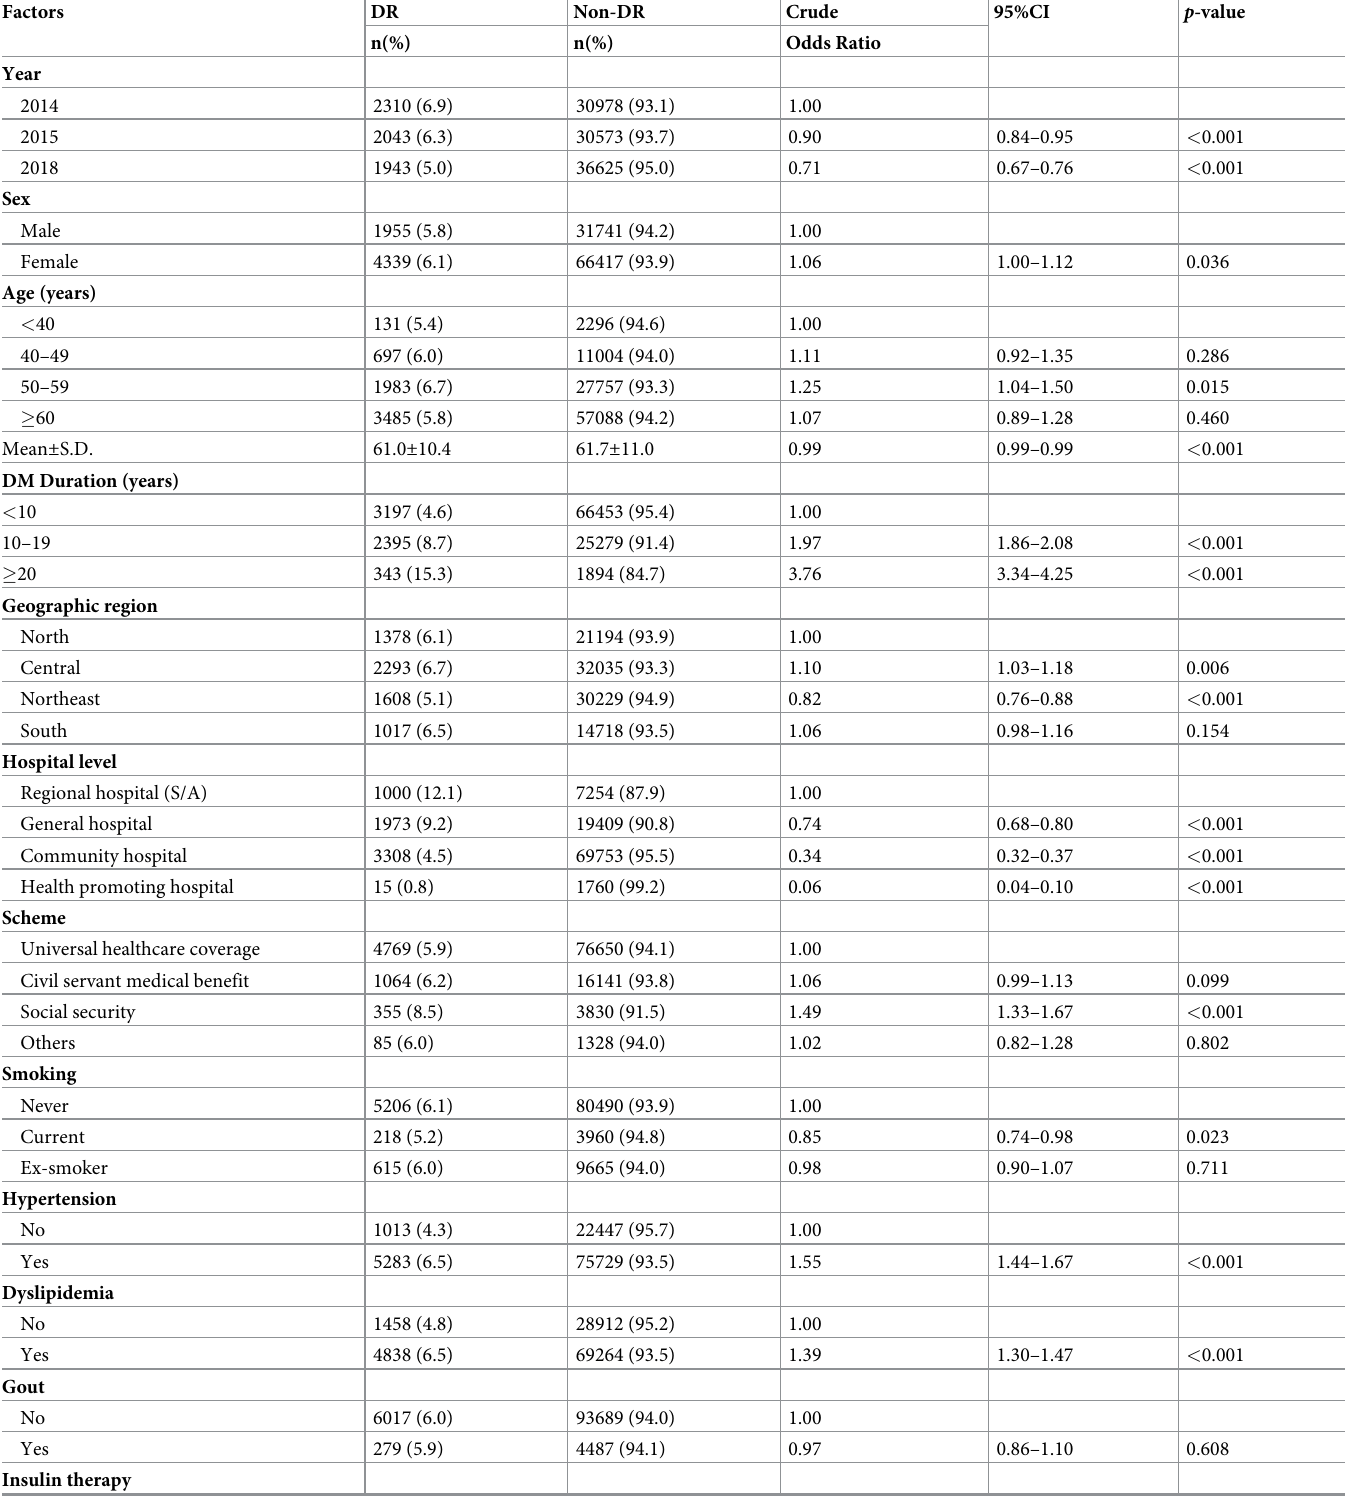
Table 3. Univariable analysis for factors associated with diabetic retinopathy (DR) among Thai patients with T2D, 2014–2018.